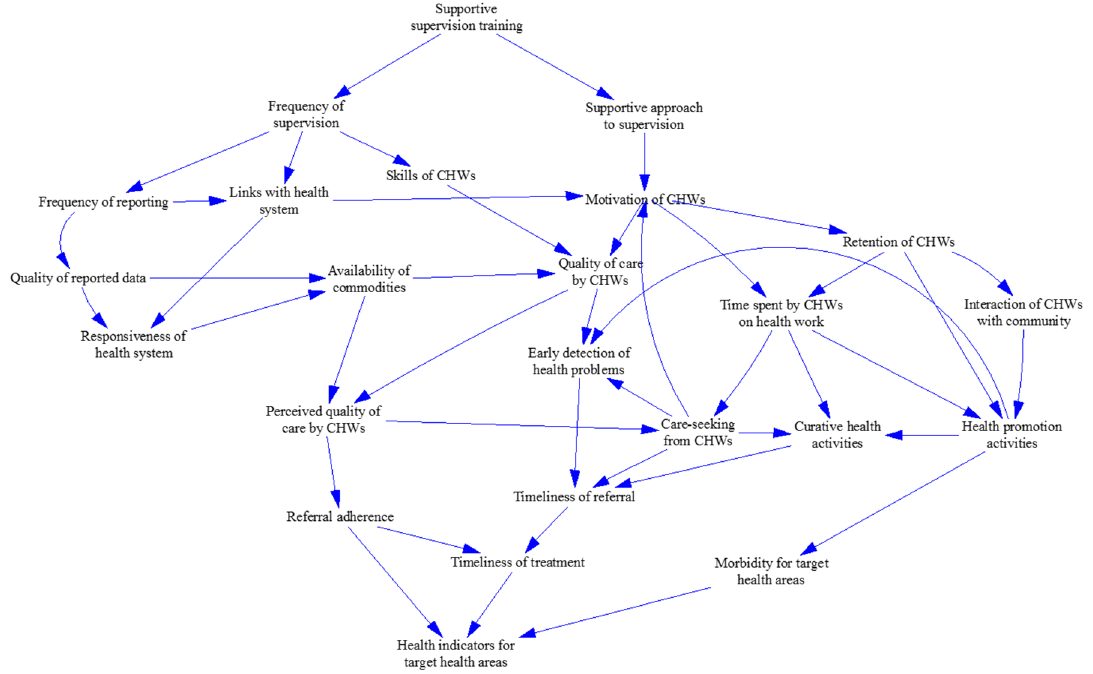
Figure 2. Conceptual model illustrating mechanisms, through which training of those supervising CHWs might result in health gains.